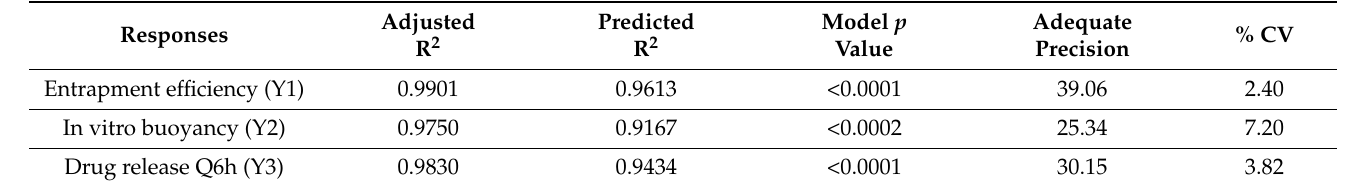
Table 3. ANOVA analysis for optimization of responses.